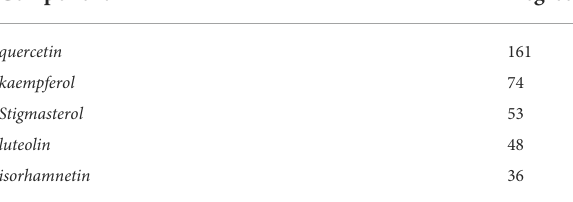
TABLE 4 Degree of the key active components of botanical drugs included.